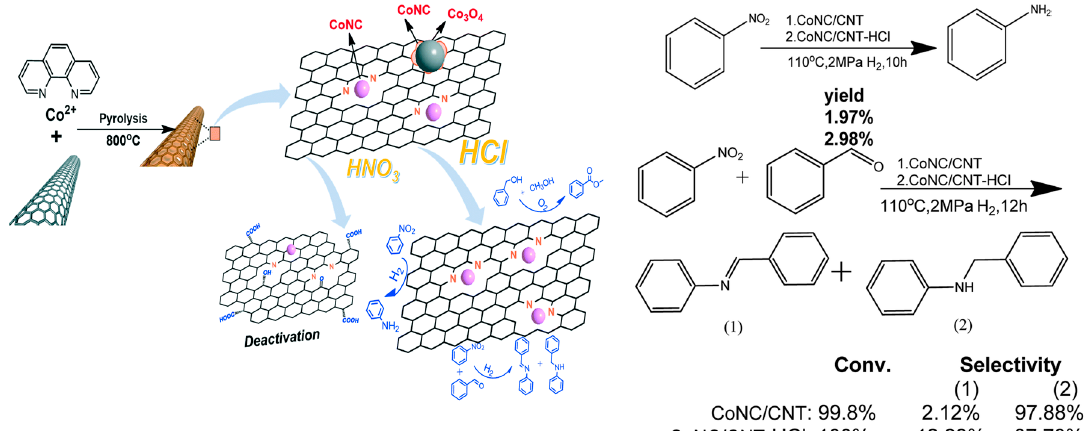
Figure 5. CoNC / CNT active sites on nitro compounds hydrogenation and hydrogenated coupling of nitrobenzene with benzaldehyde. Reproduced from [41], with permission from Royal Society of Chemistry,